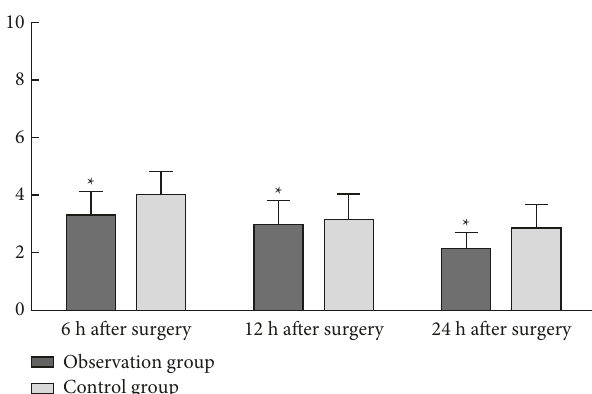
Figure 1: Comparison of pain scores between the groups treated with maxillary sinus external/internal lift. Note. Compared with the group treated with maxillary sinus external lift,